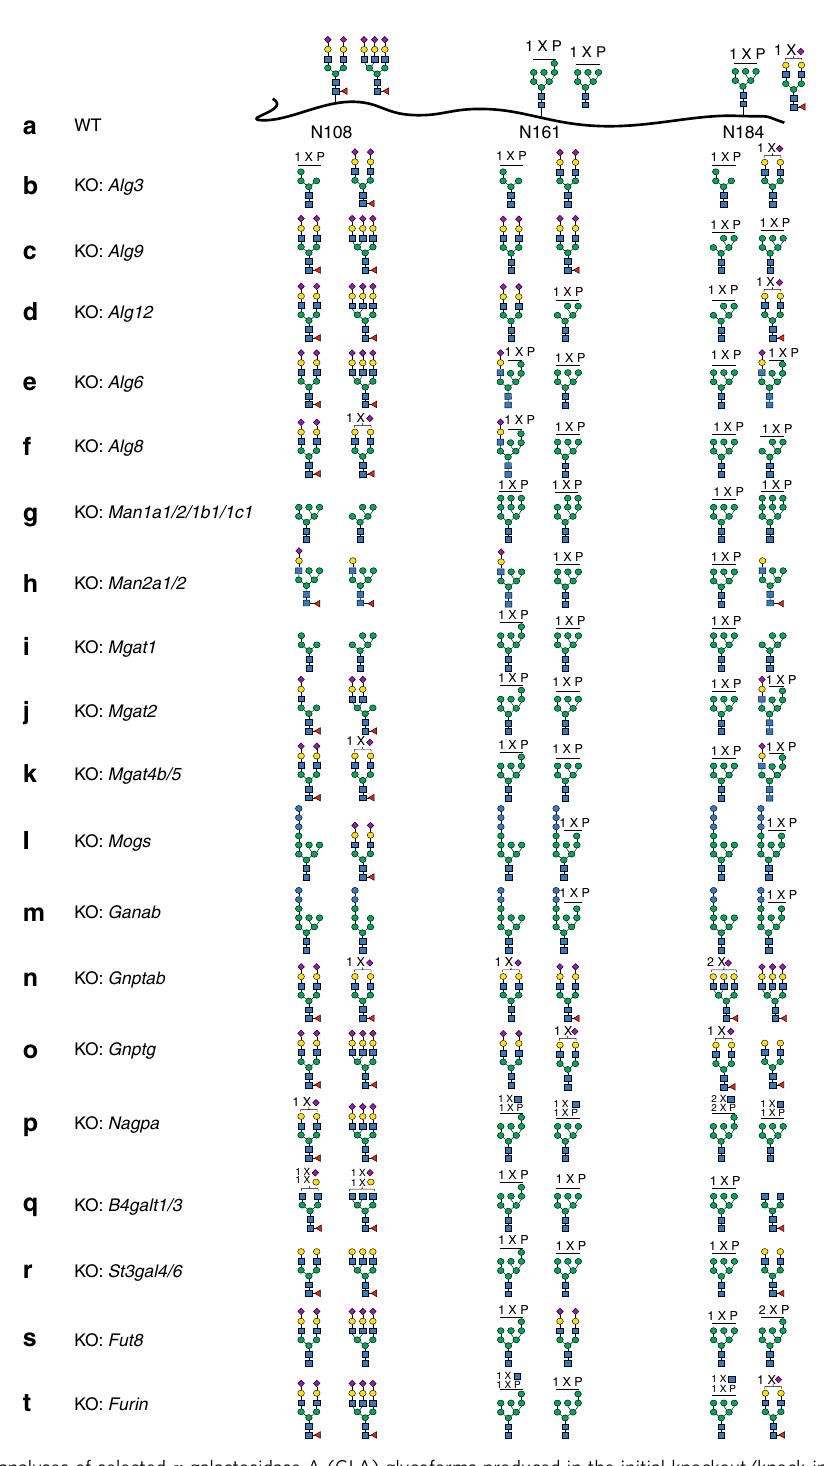
Fig. 2 Site-speci fi c glycan analyses of selected α -galactosidase A (GLA) glycoforms produced in the initial knockout/knock-in (KO/KI) CHO cell screen. a The two most abundant glycan structures at N-glycosites (N108, N161, and N184) of GLA produced in CHO wild type (WT) are shown, and in b – t the two most abundant glycans for GLA produced in engineered CHO clones are shown as indicated. The detailed N-glycan analyses of all GLA glycoforms are shown in Supplementary Fig. 2 together with additional variants. Each glycan structure was con fi rmed by targeted tandem mass spectrometry (MS/MS) analysis (Supplementary Fig. 5). Details regarding the stacking ancestry and sequence analysis are shown in Supplementary Table 2 and Supplementary Data